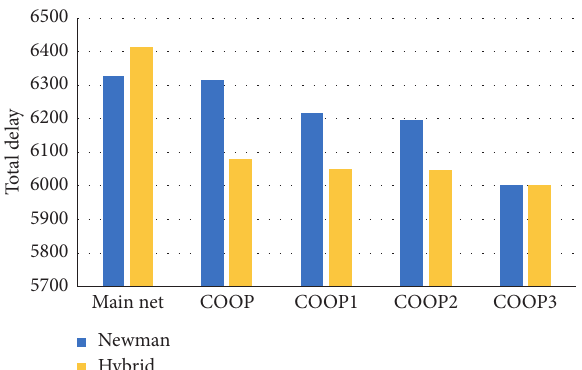
Figure 7: Comparison between Newman clustering and Hybrid clustering (the delay is given in seconds).